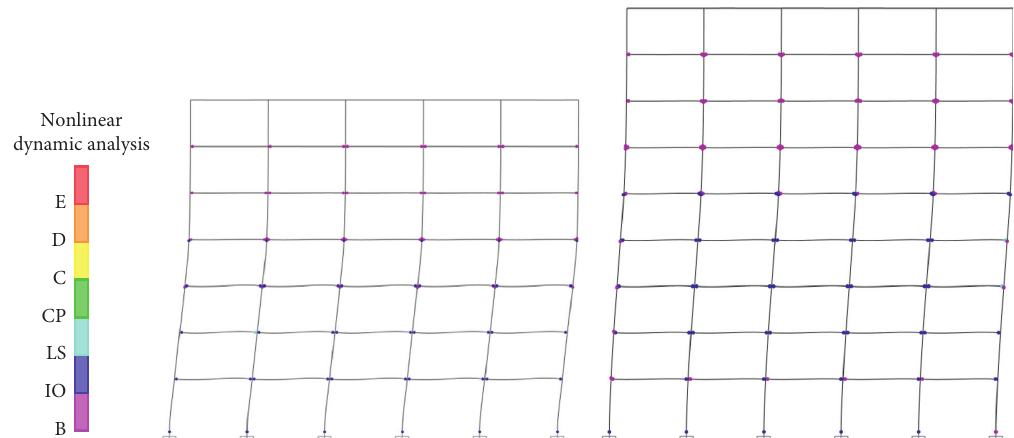
Figure 10: Distribution of plastic hinges. Nonlinear dynamic analysis of 5-bay RC frames under the Bevagna earthquake.